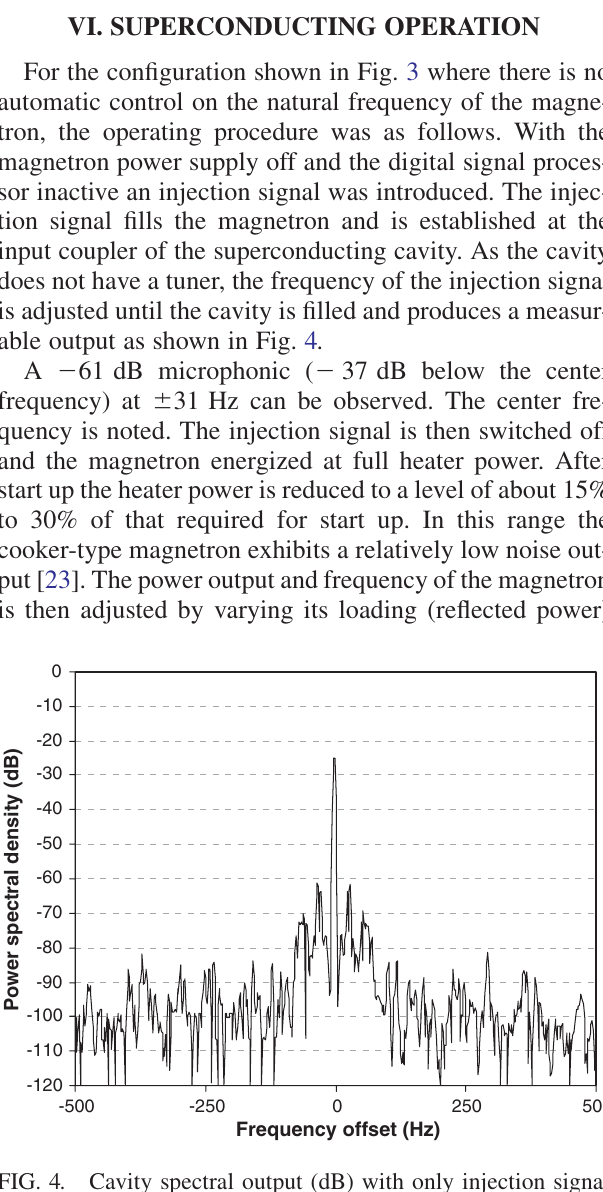
FIG. 4. Cavity spectral output (dB) with only injection signal as input. Resolution bandwidth RBW ¼ 3 Hz